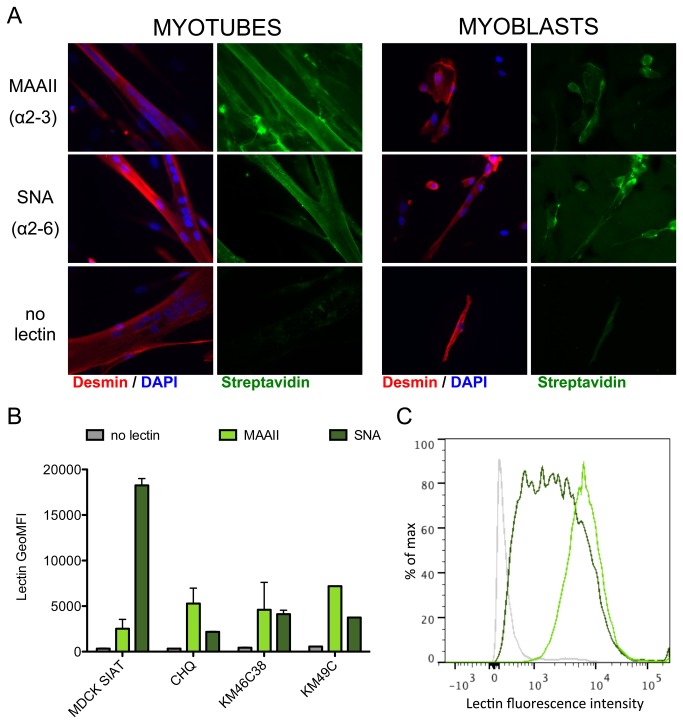
Detection of sialic acids at the surface of human muscle cells.
A. α2-3 and α2-6 linked sialic acids were detected on non-permeabilized muscle cells (myoblasts and myotubes) from donor CHQ by using the biotinylated lectins MAAII and SNA, respectively. Lectin binding was further revealed by Streptavidin-A488 staining (green), and cells were permeabilized for detection of intracellular desmin (red) by immunofluorescence.
B. The MAAII and SNA lectins were used for the detection of the two types of sialic acids by cytofluorometry, on non-permeabilized myoblasts from 3 different donors (CHQ, KM46C38, KM49C) and MDCK-SIAT cells as a control. Cells were then permeabilized for the staining of NCAM. The geometric mean of fluorescence intensity (GeoMFI) for each condition (no lectin, grey; MAAII, light green; SNA, dark green) is given for the total population of MDCK cells (which were NCAM-negative) and for the NCAM-positive population in myoblast cultures. Data are the mean of two duplicates with standard deviation as error bar, and represent two independent experiments.
C. Distribution of the lectin staining intensities in the NCAM-positive population of CHQ myoblasts stained with MAAII (light green) and SNA (dark green).